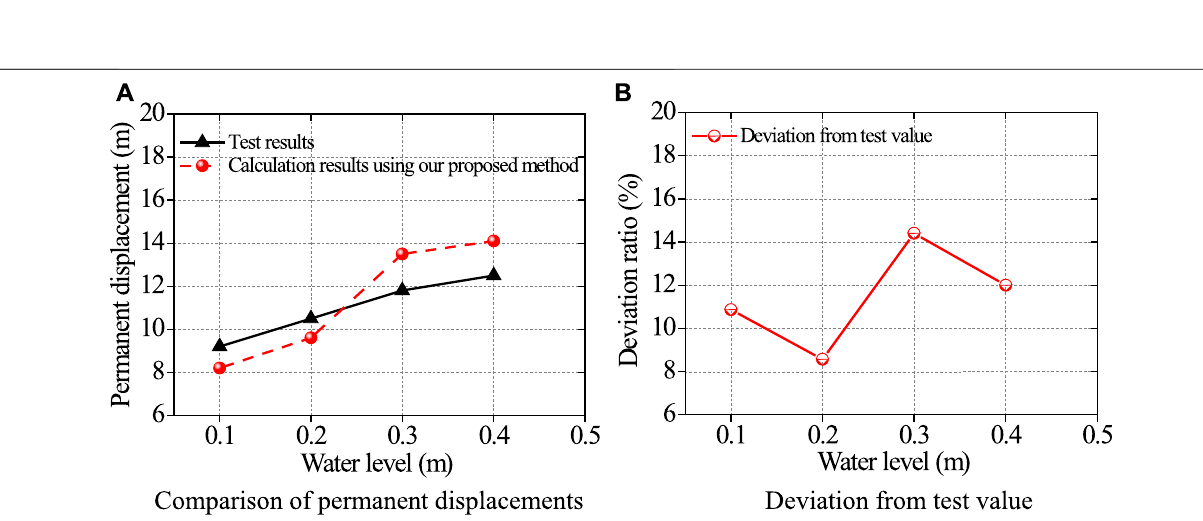
Frontiers in Earth Science |